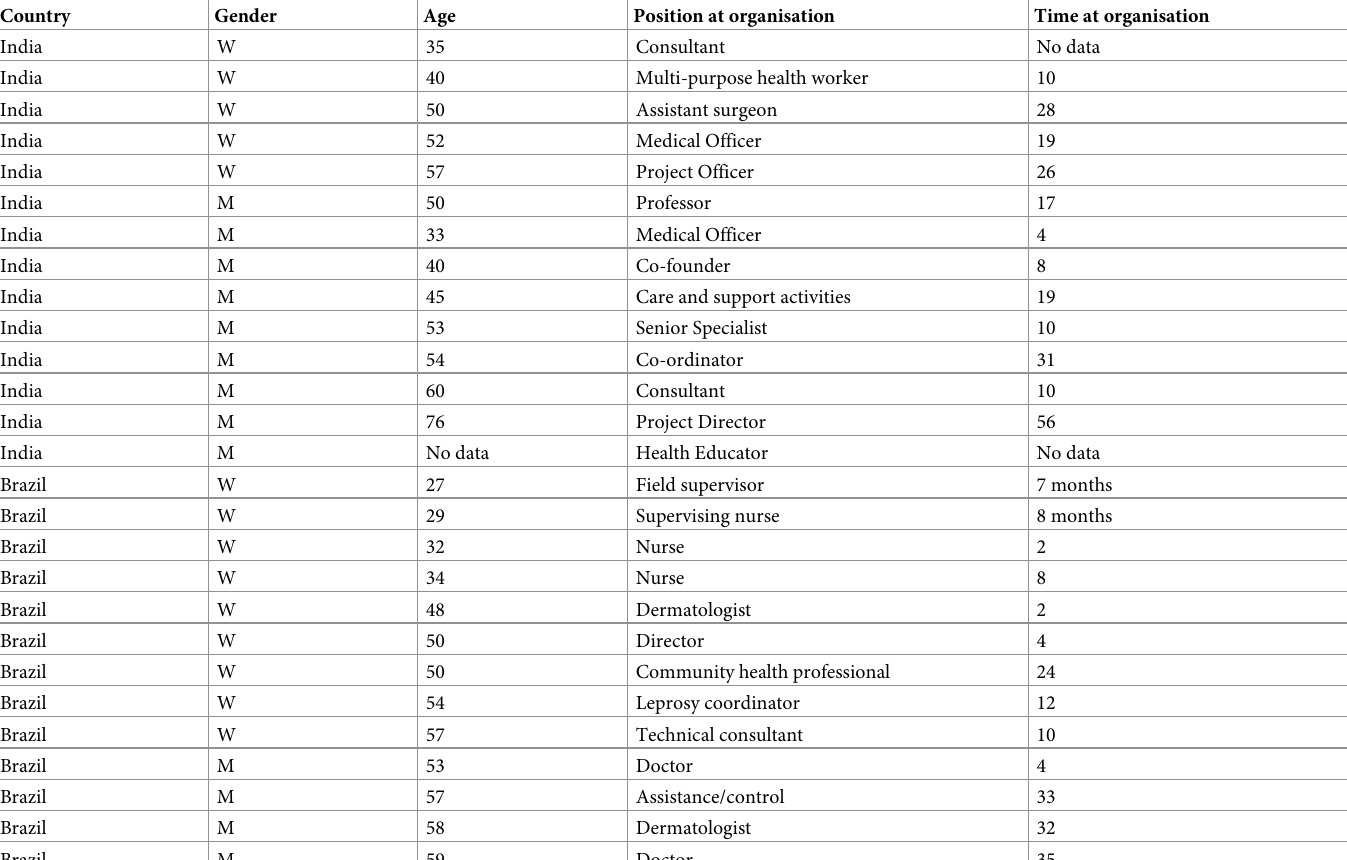
Table 1. Professional profiles of